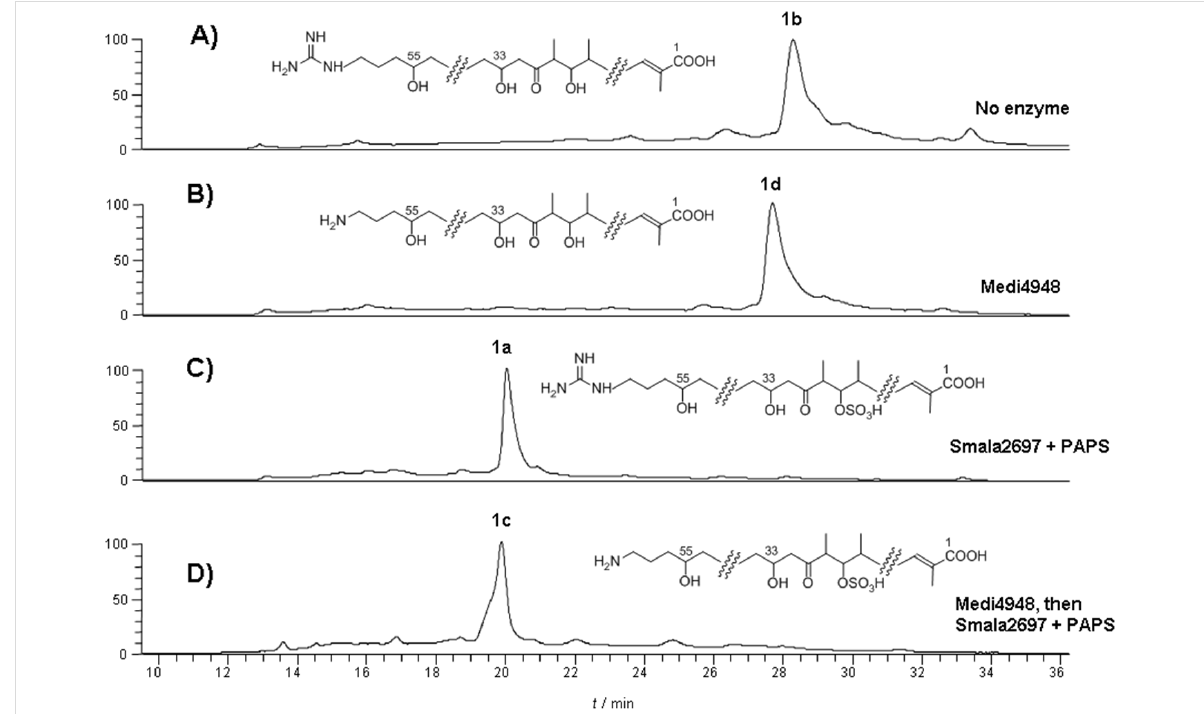
Figure 3: HPLC–UV–MS analysis of in vitro assays with amidinohydrolase Medi4948 and sulfotransferase Slf from S. malaysiensis DSM4137 (SMALA_2697). A) LC–UV (360 nm) trace of control assay, where purified 1b at m/z 1138.8 ([M + H] + ) was incubated without enzyme. B) LC–UV (360 nm) trace of 1b incubated with amidinohydrolase Medi4948, showing complete convertion of desulfoclethramycin ( 1b ) to its amino form mediomycin B ( 1d ) at m/z 1096.8 ([M + H] + ). C) LC–UV (360 nm) trace of 1b incubated with sulfotransferase SMALA_2697 and PAPS, showing com- plete convertion of desulfoclethramycin ( 1b ) to its sulfonated form clethramycin ( 1a ) at m/z 1240.8 ([M + Na] + ). D) LC–UV (360 nm) trace of 1b incu- bated with amidinohydrolase Medi4948 to generate mediomycin B ( 1d ) in situ, followed by addition of sulfotransferase SMALA_2697 and PAPS